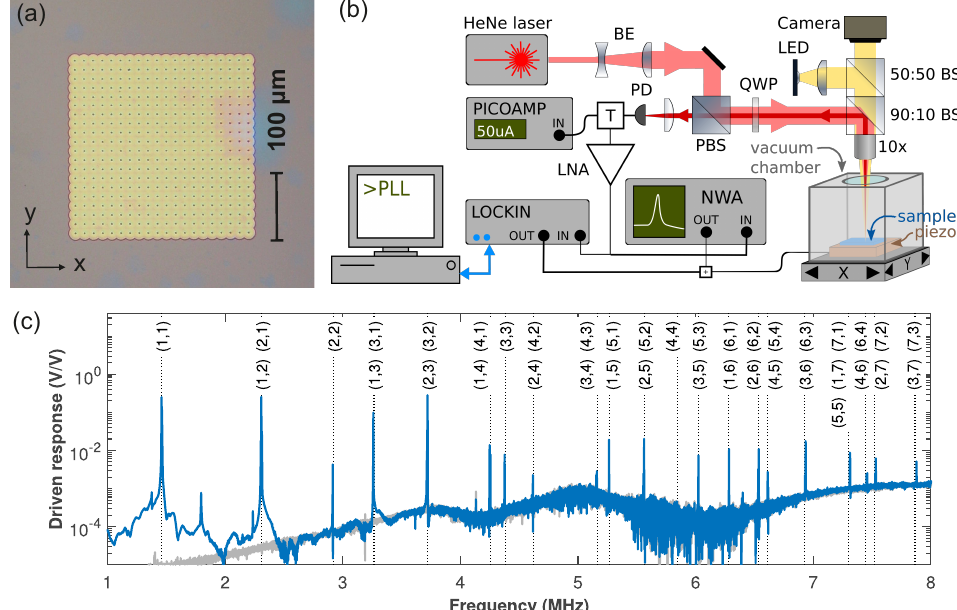
Figure 1. ( a ) Optical micrograph of the membrane ( b ) Schematic overview of the measurement setup. BE: beam expander, (P)BS: (polarizing) beam splitter, QWP: quarter wave plate, PD: photodetector, LNA: low-noise amplifier, NWA: network analyzer, T: bias tee, +: combiner, LED: light emitting diode for illumination. ( c ) Driven response of the membrane measured using the NWA (blue) with the calculated frequencies (Equation (2)) as black dashed lines and the mode numbers